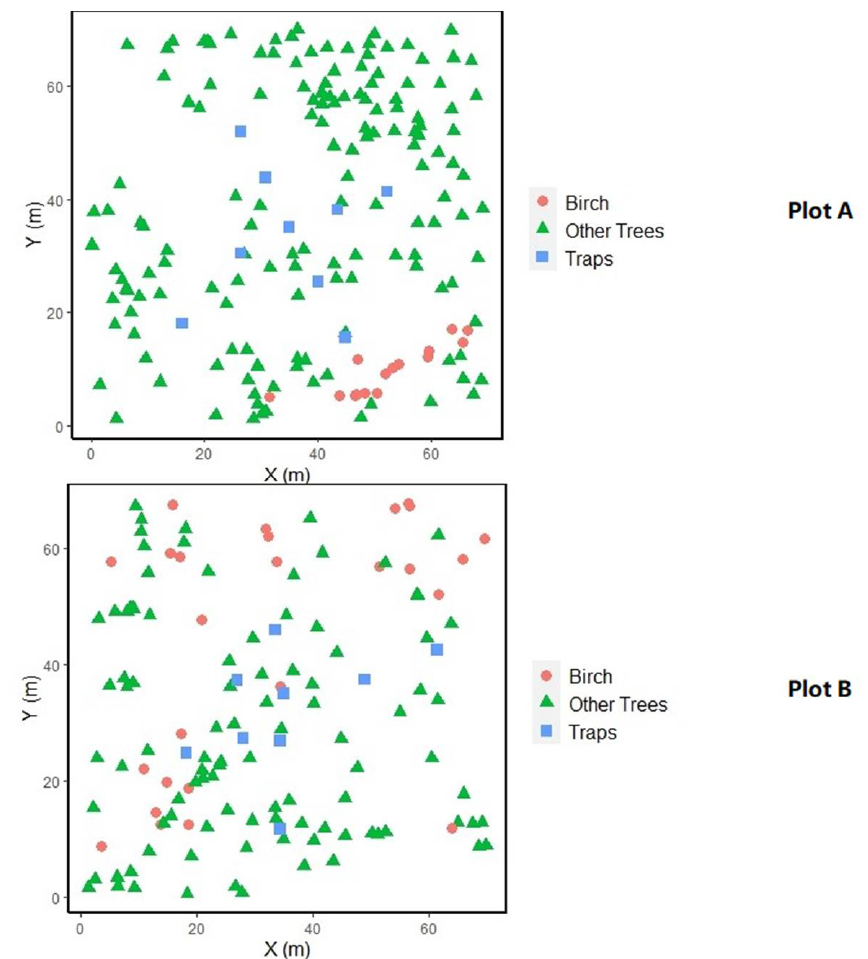
Figure 1. Tree distribution maps of study plot A (top) and B (bottom).